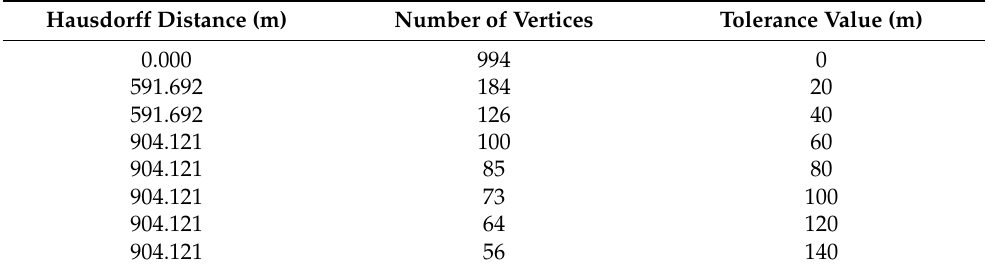
Table 2. Computation of Hausdorff distances per tolerance value (line #1027).